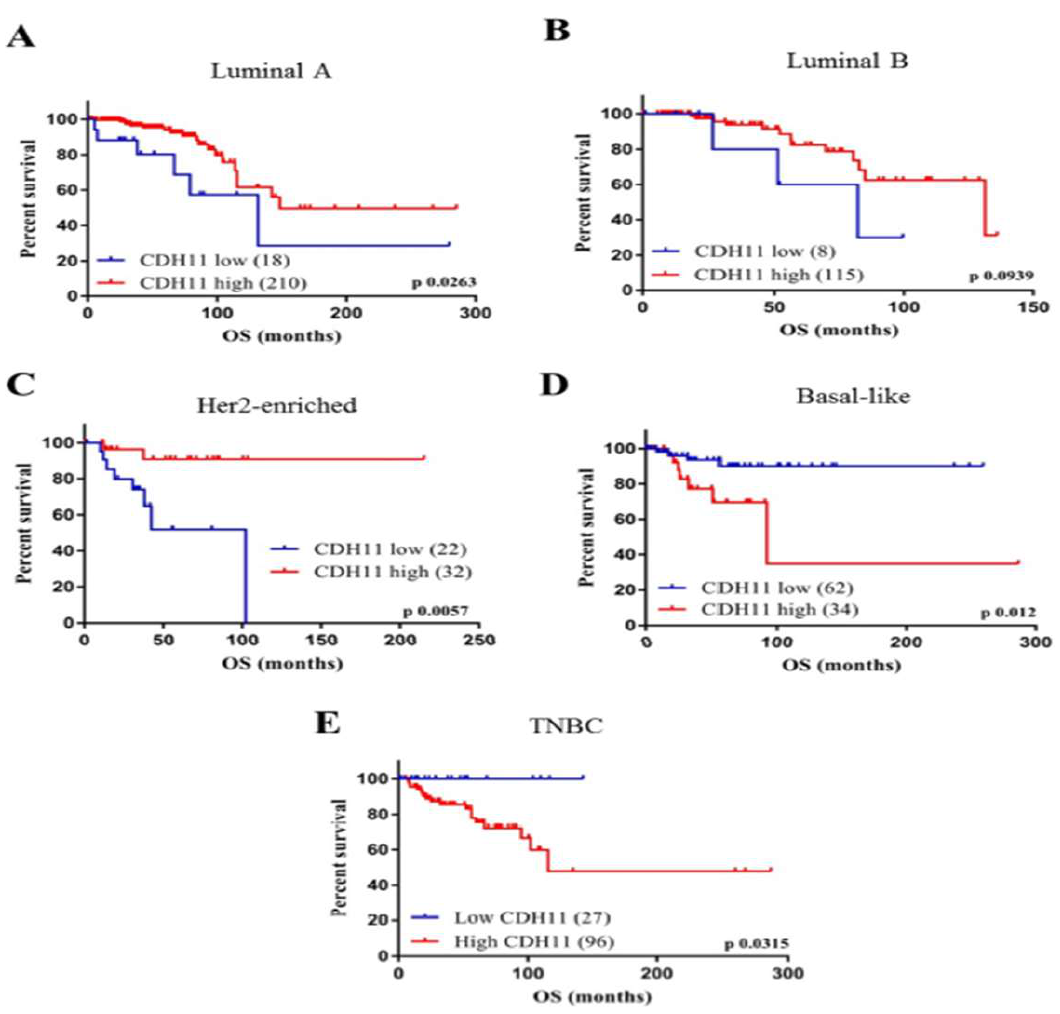
Figure 1. Patients with TNBC and basal-like breast cancer exhibiting high expression of CDH11 are characterized by worse prognosis. Kaplan-Meier plots based on analyses of breast cancer cohort ( n = 1247) using the TCGA Breast Cancer (BRCA) cohort datasets show the effect of CDH11 expression on the overall survival rates in patients regardless of molecular subtype, ( A ) Luminal A, ( B ) Luminal B, ( C ) Her2-enriched, ( D ) Basal-like, or (E) Triple negative breast